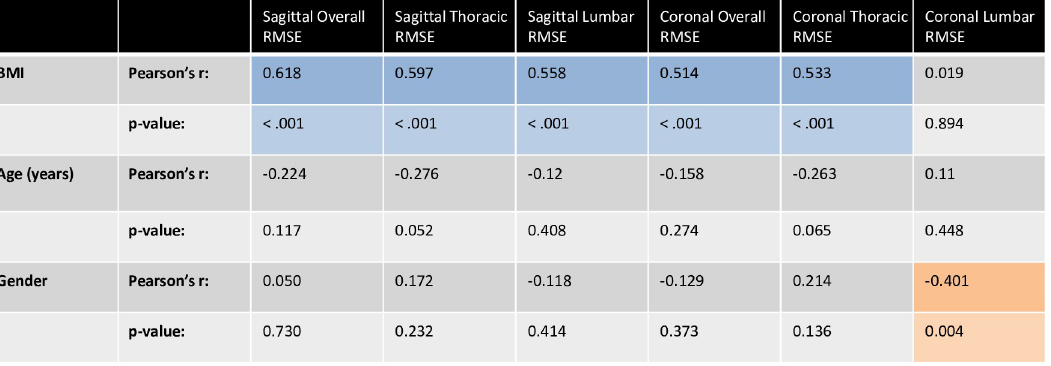
Fig 5. Correlations between BMI, Age, Gender and the FMP to SCP RMSD in the sagittal and coronal planes, in the overall spine (T1 to L5), lumbar spine (L1 to L5) and thoracic spine (T1 to T12). Pearson’s r and p-value calculated in Jamovi are given for each set of correlations. A Pearson’s r value of ± 0.5 to ± 1 indicates a strong correlation (blue), ± 0.3 to ± 0.49 (orange) indicates a moderate correlation and ± 0.29 to 0 indicates low correlation (grey). The p-value indicates the statistical significance of the correlations, where p < 0.05 indicates the correlation is statistically significant. Gender was analysed such that Female = 1 and Male =